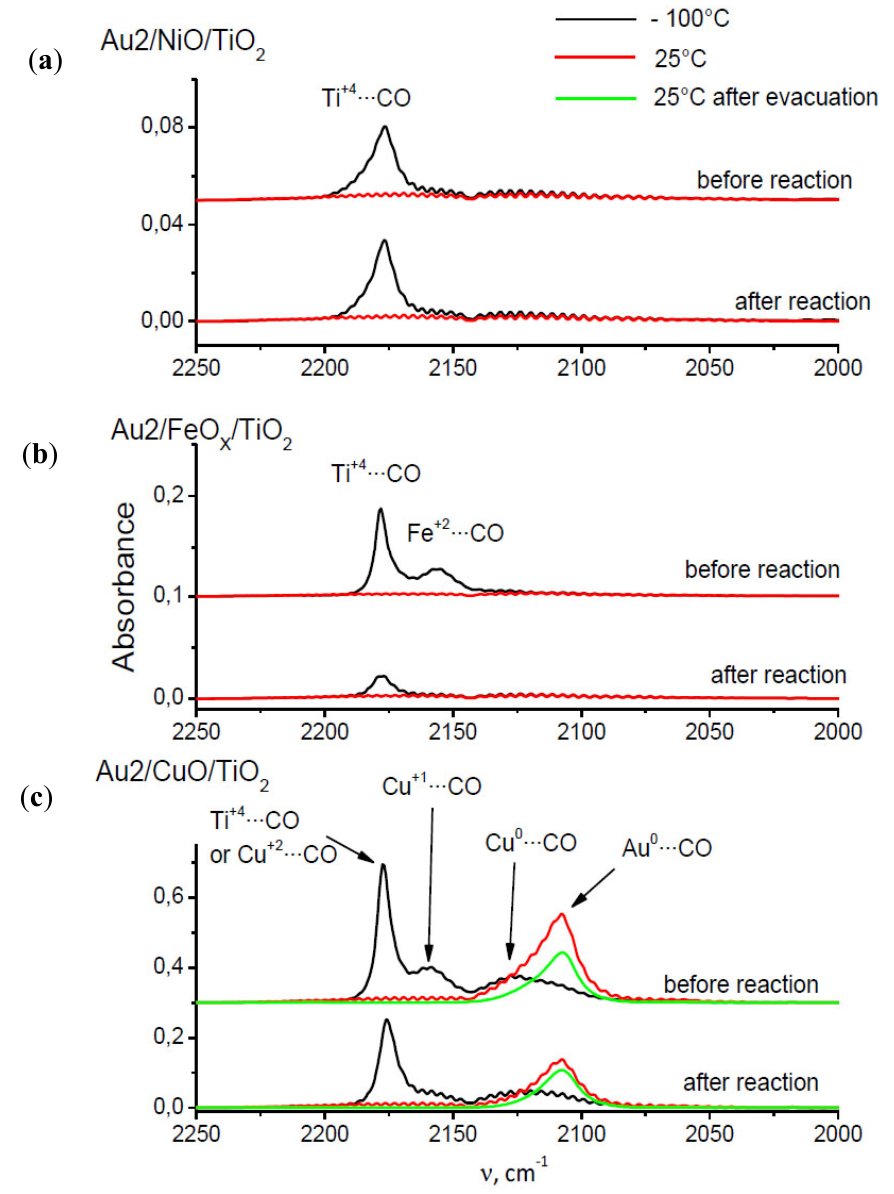
catalysts promoted 2